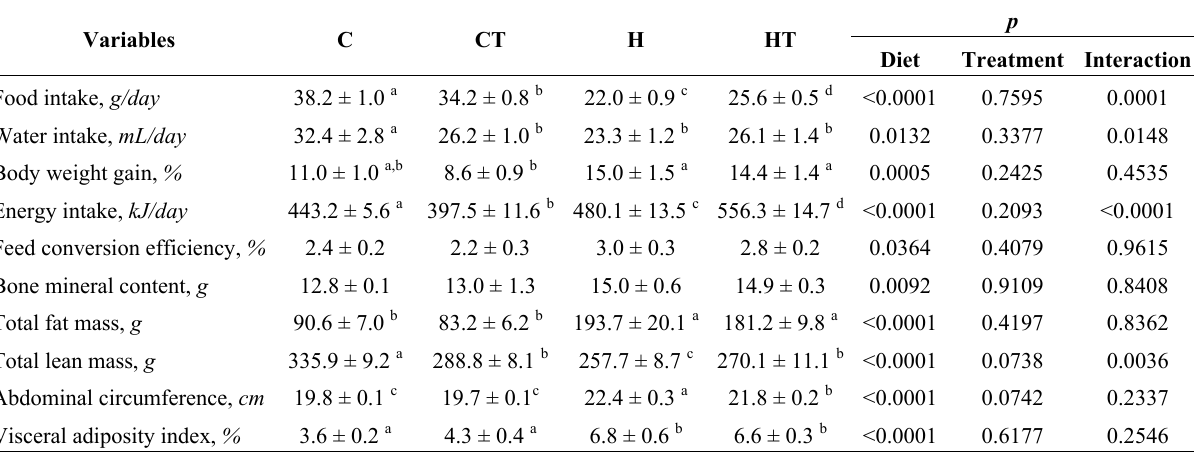
Table 2. Dietary intakes, body composition, metabolic indices and organ wet weights in C, CT, H and HT diet-fed